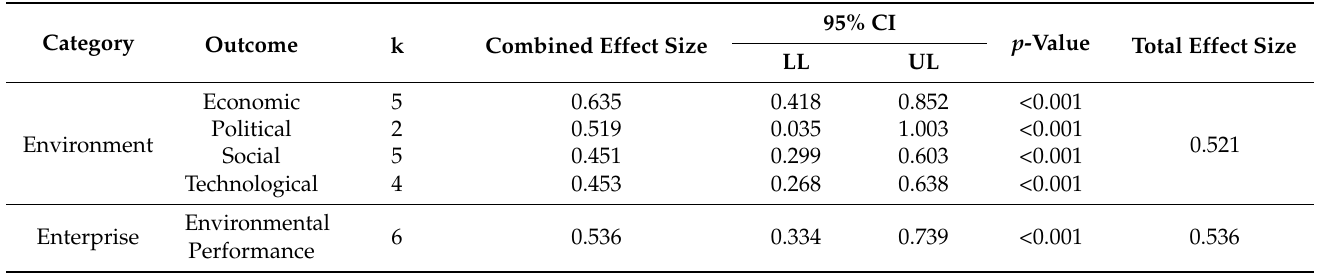
Table 5. The main effect